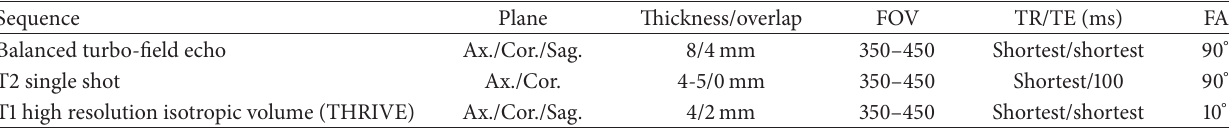
Table 2: MRE sequences.